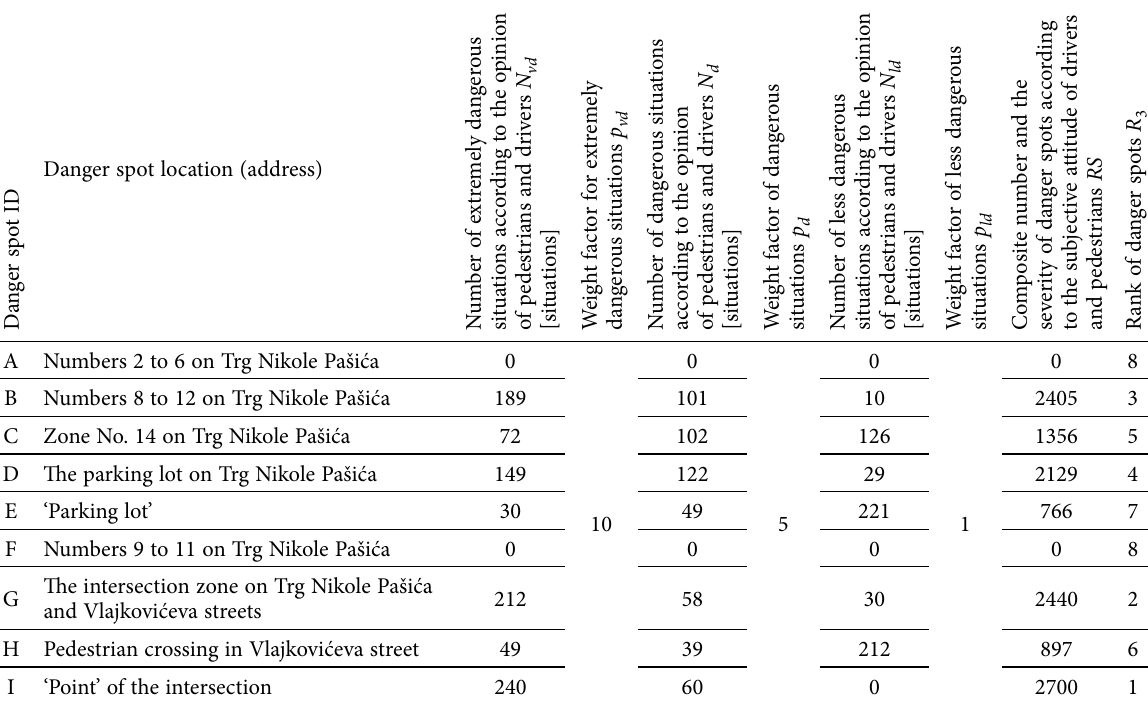
Table 3. Ranking danger spots based on the subjective attitude of drivers and pedestrians (Vujanić et al. 2009b)